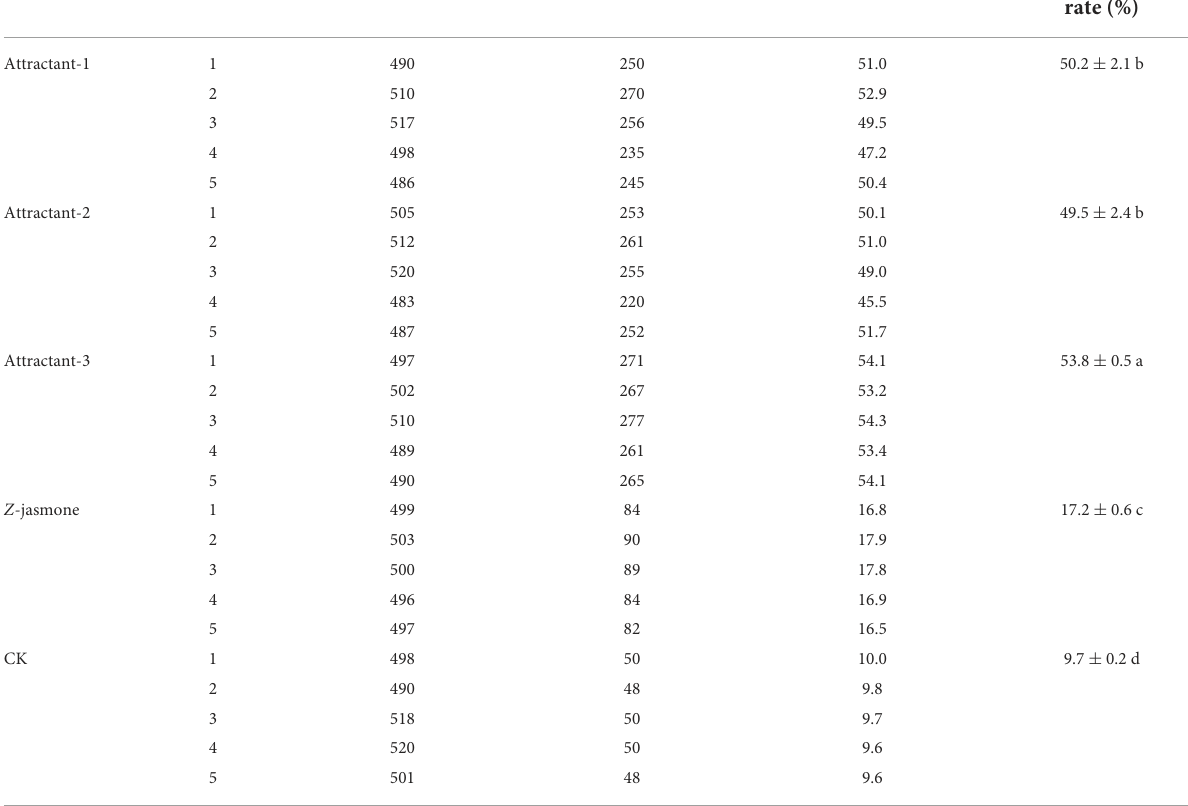
TABLE 6 Parasitism rates of tea aphids by Aphelinus sp. enticed and regulated by three attractant mixtures and Z -jasmone in comparison with untreated CK (Field trial 1).